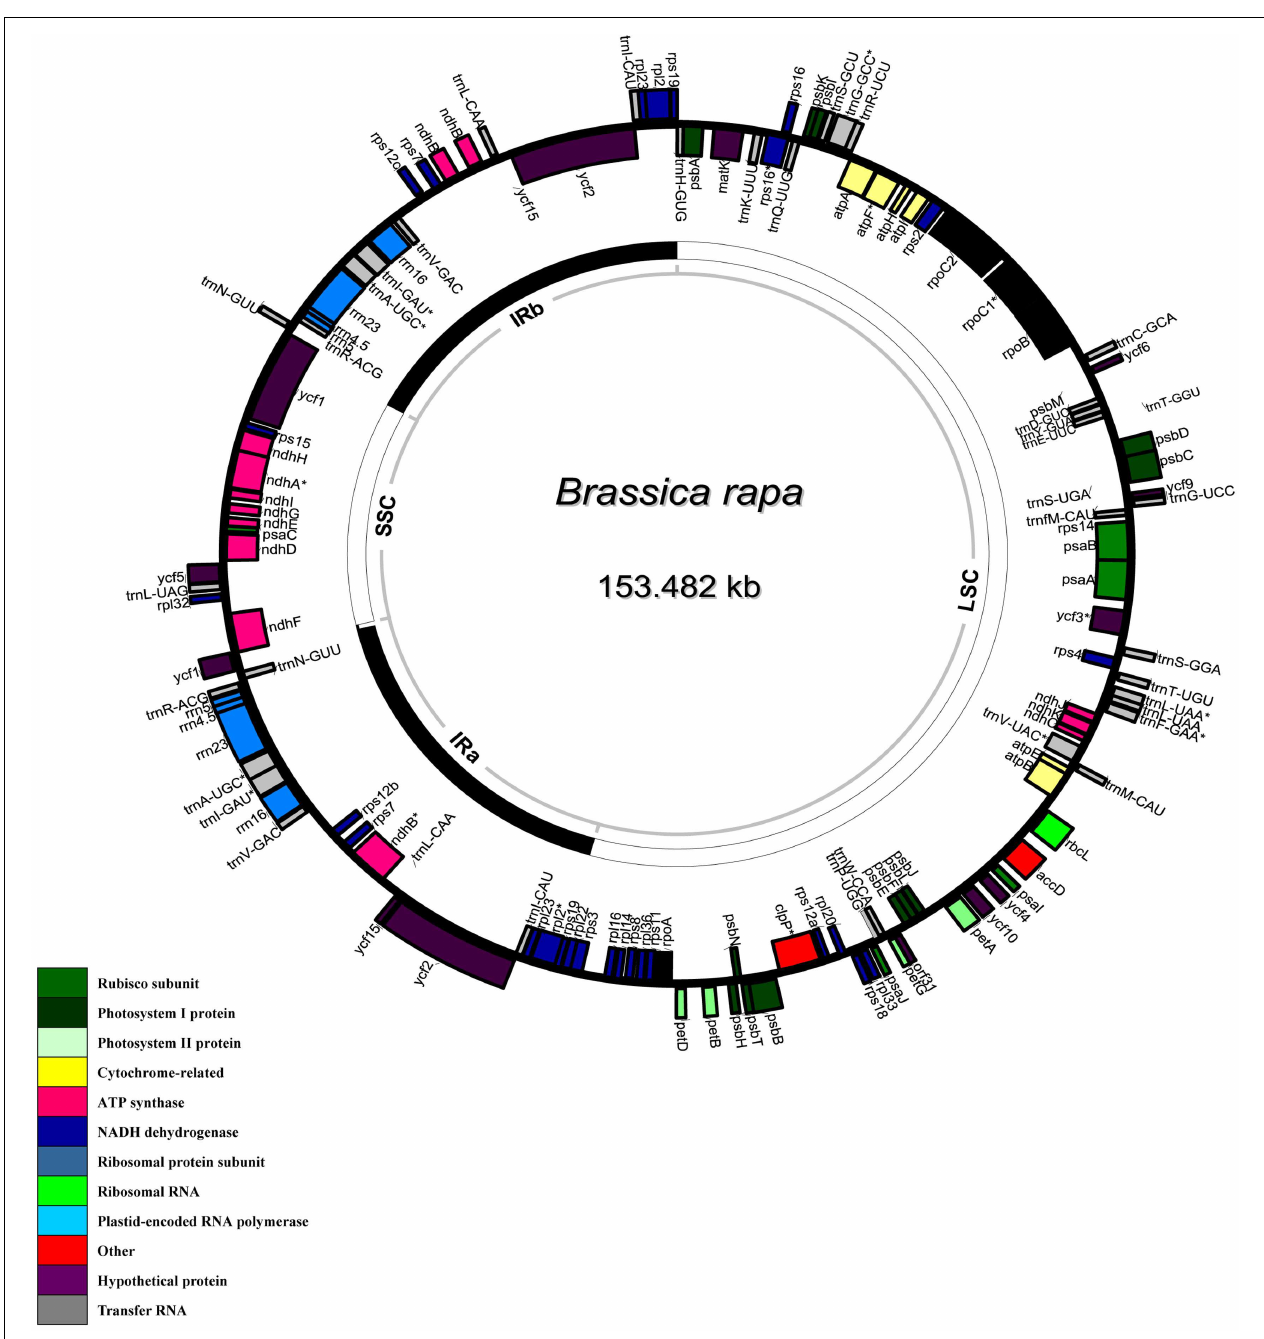
83,282bp) single copy regions. Genes on the outside of the map are transcribed in the clockwise direction and genes on the inside of the map are transcribed in the counterclockwise